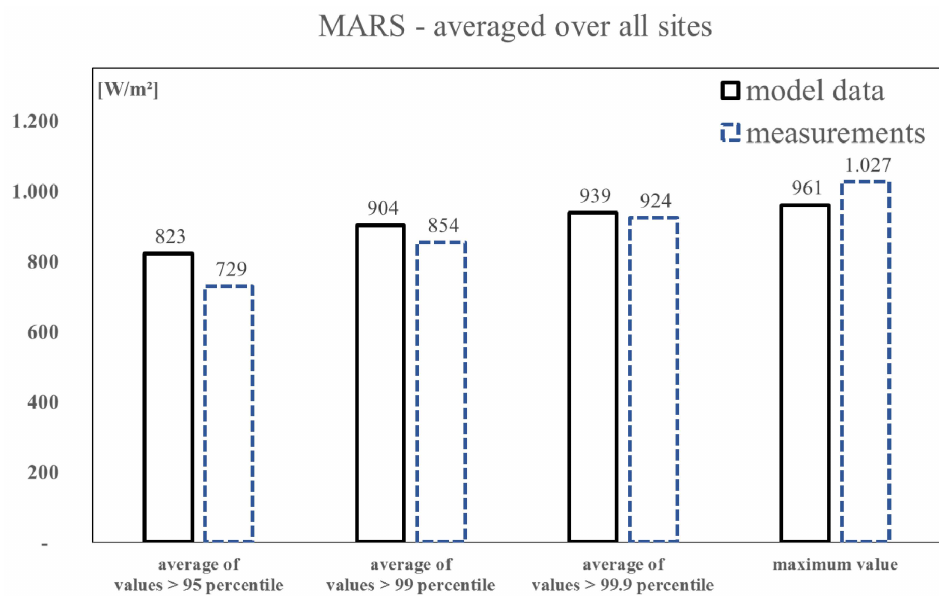
Figure 4. Maximum amplitude of irradiation supply (MARS) for different percentiles.